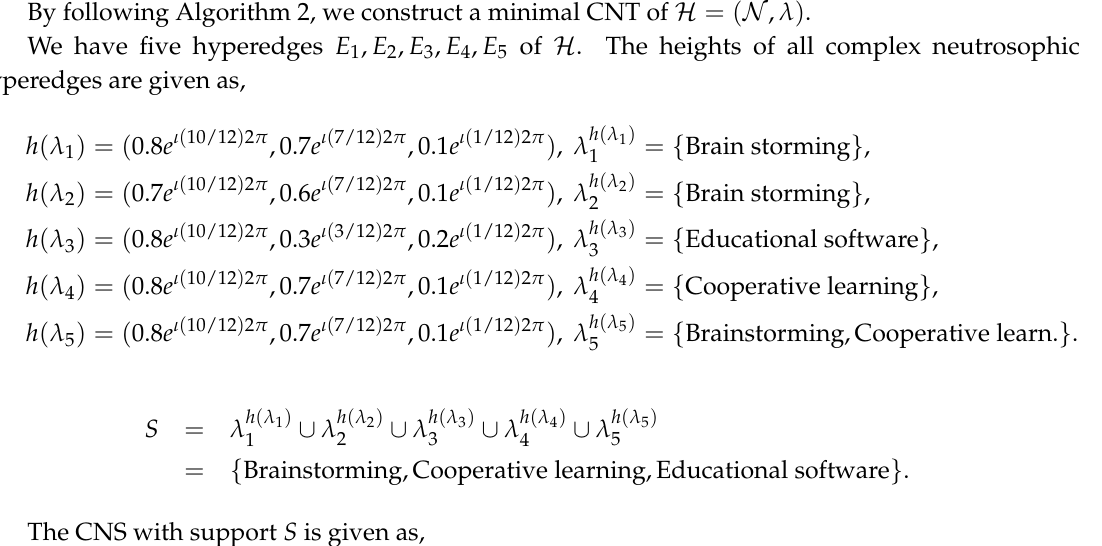
Figure 10. Complex neutrosophic hypergraph model of modern teaching